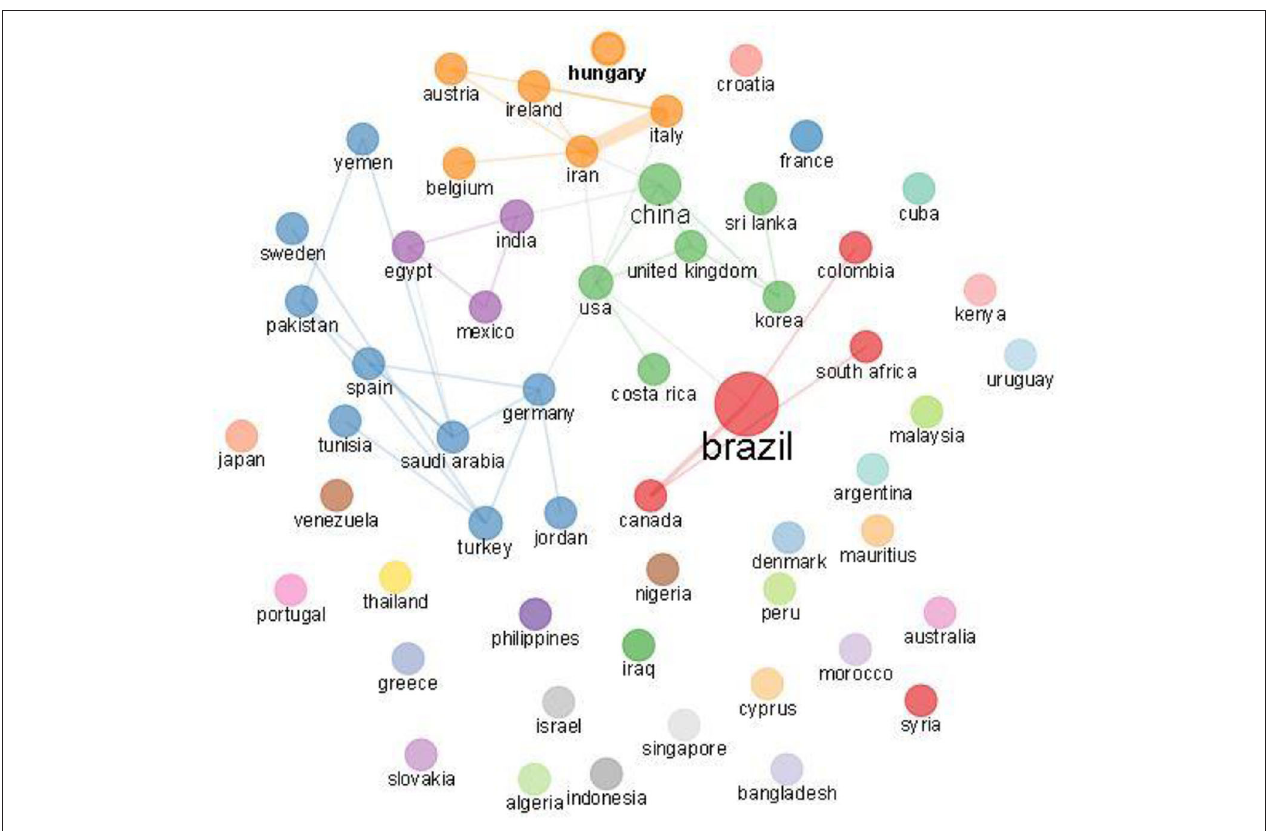
FIGURE 6 | Thirty nations’ collaboration networks on research out-puts on citrus waste and animal feed from 1961 to 2020.